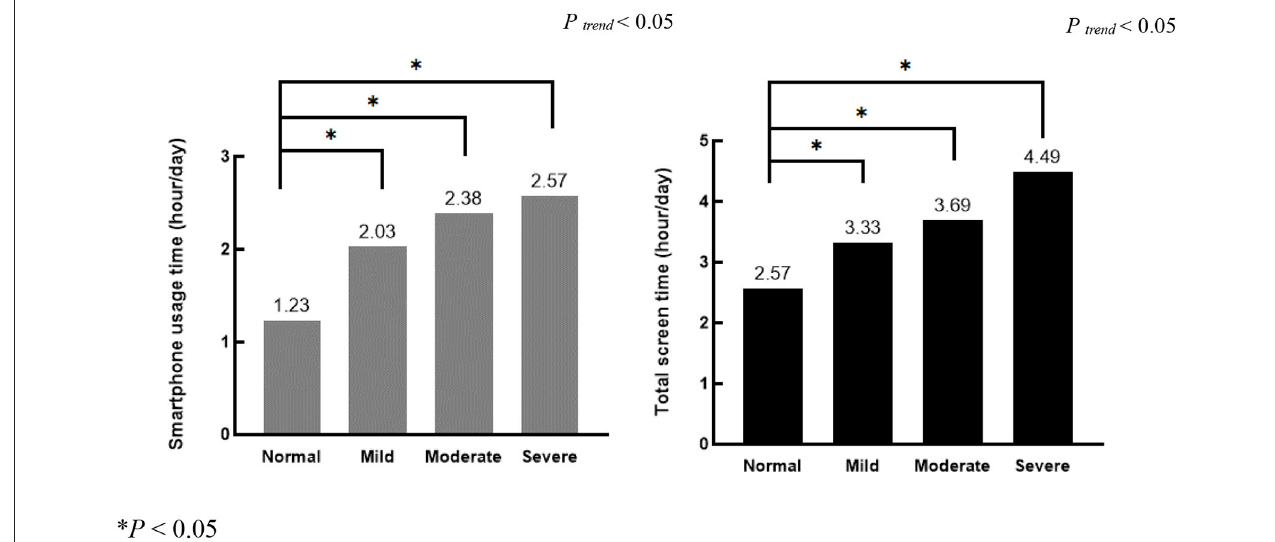
FIGURE 2 | Variance analysis for smartphone use time and total screen time in the different academic stress